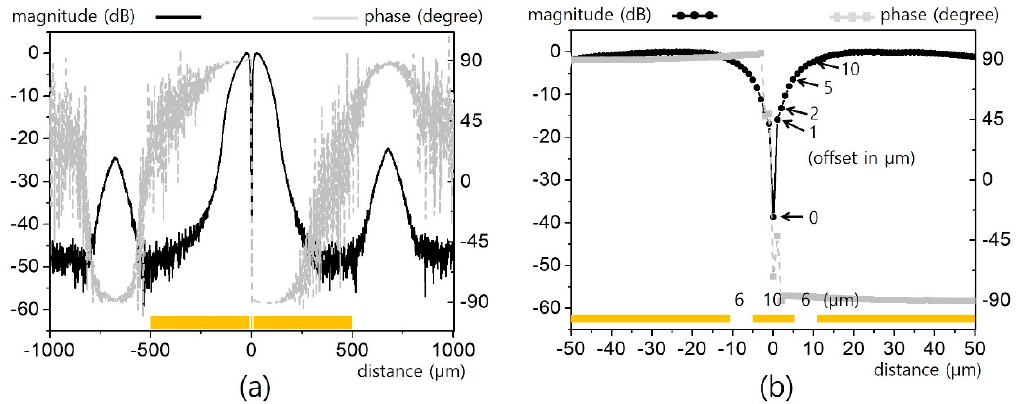
Figure 2. Horizontal electric field distribution over a coplanar waveguide (CPW) ( n = 1, L = 10 μ m, and G = 6 μ m): ( a ) macroscopic view, and ( b ) microscopic view.